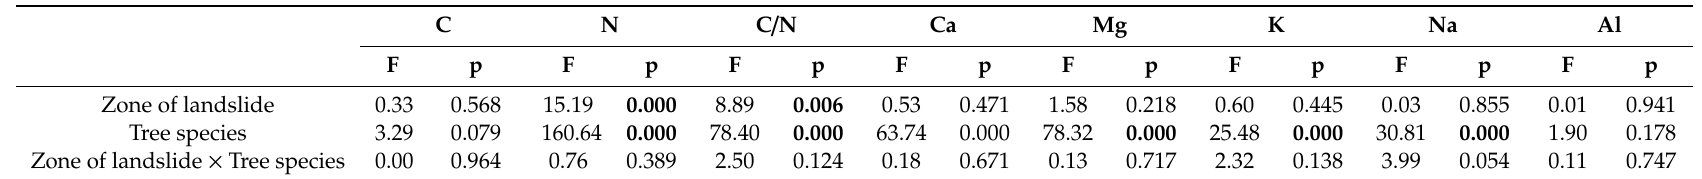
Table 6. Results of general linear model (GLM) analysis for macronutrients, including the zone of landslide and tree species.